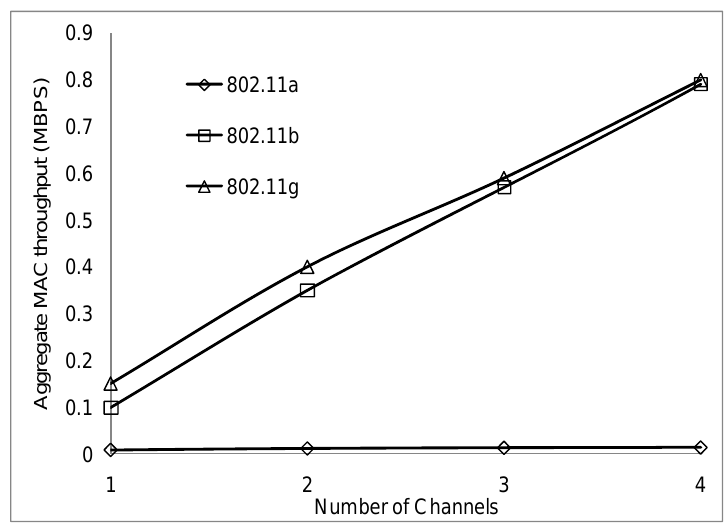
Figure 25. Aggregate throughput at 100 m range and data rate of 2